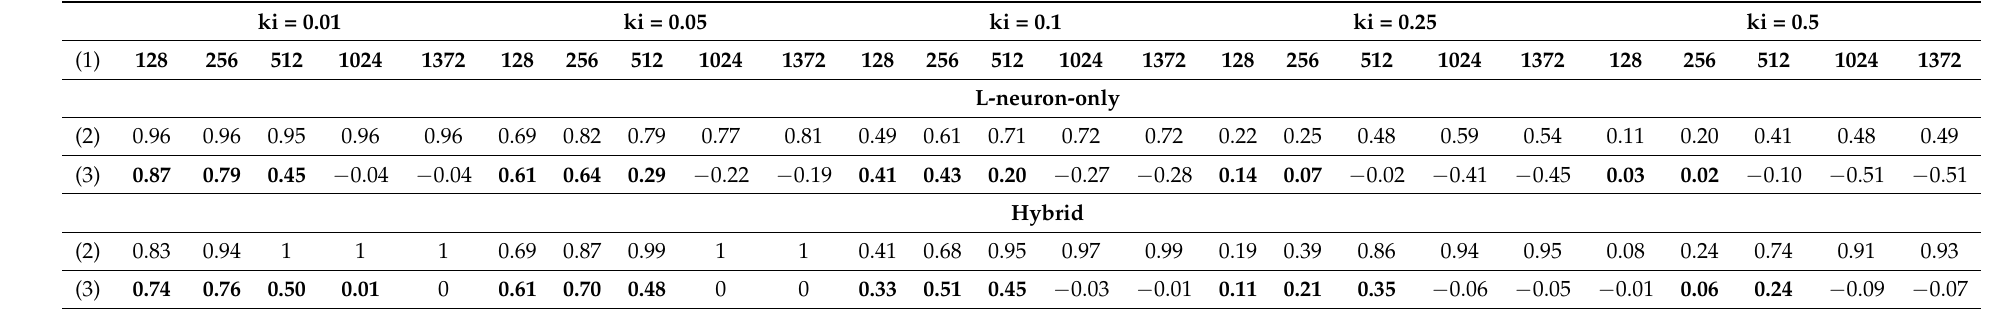
Table 1. Aggregated values of the J statistics for the L-neuron-only and hybrid architectures evaluated on test subsets. The size of considered datasets is shown in row (1), rows designated with (2) are the mean values of J statistics for 25 trials and those designated with (3) present performance gains with respect to the ‘larger’ reference neural network. Labels ki indicate levels of knowledge impairment. Gains in performance are marked in bold